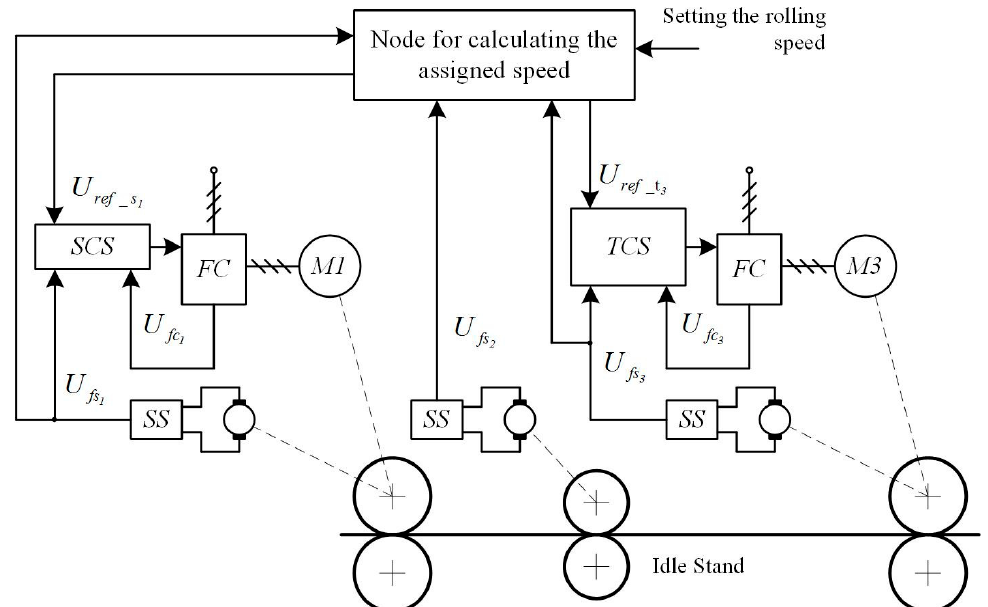
Figure 12. Functional layout of the control system with control of the friction force reserve in the deformation zones: node for calculating the assigned speed; setting the rolling speed; SCS, automatic control system for speed/pressure position; idle stand; SS, speed sensor.